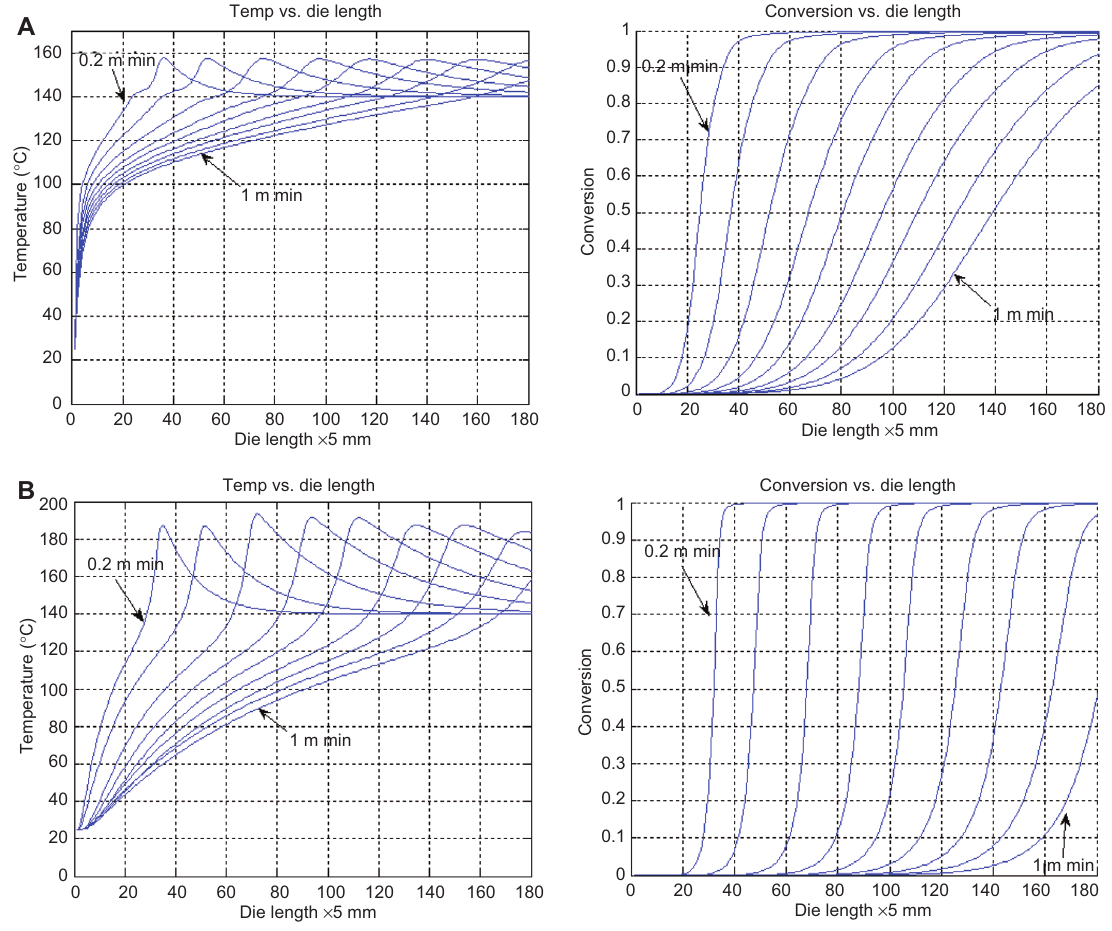
Figure 3 (A) Temperature and cure die interface and (B) temperature cure at